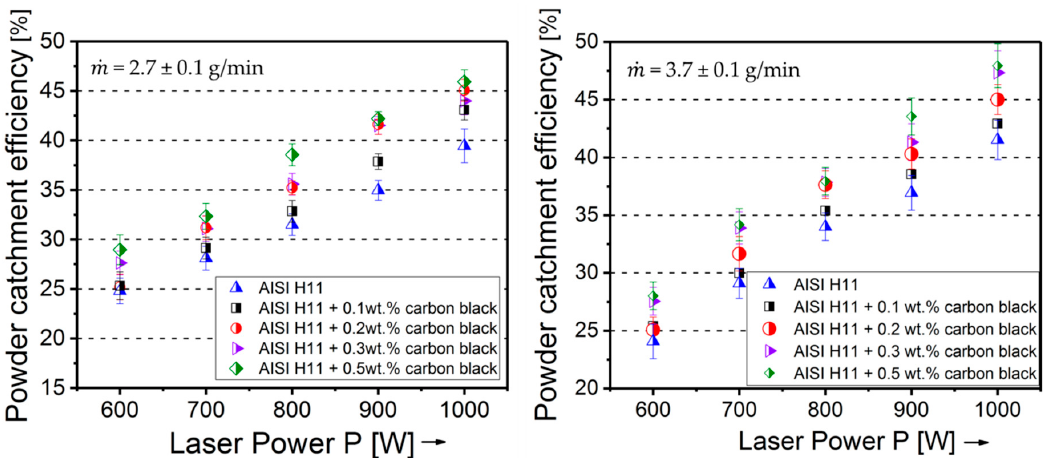
Figure 7. Powder catchment efficiency of single weld tracks deposited with the analyzed tool steel powder mixtures as a function of laser power and a powder mass flow of 2.7 g/min ( left ) and 3.7 g/min ( right ).